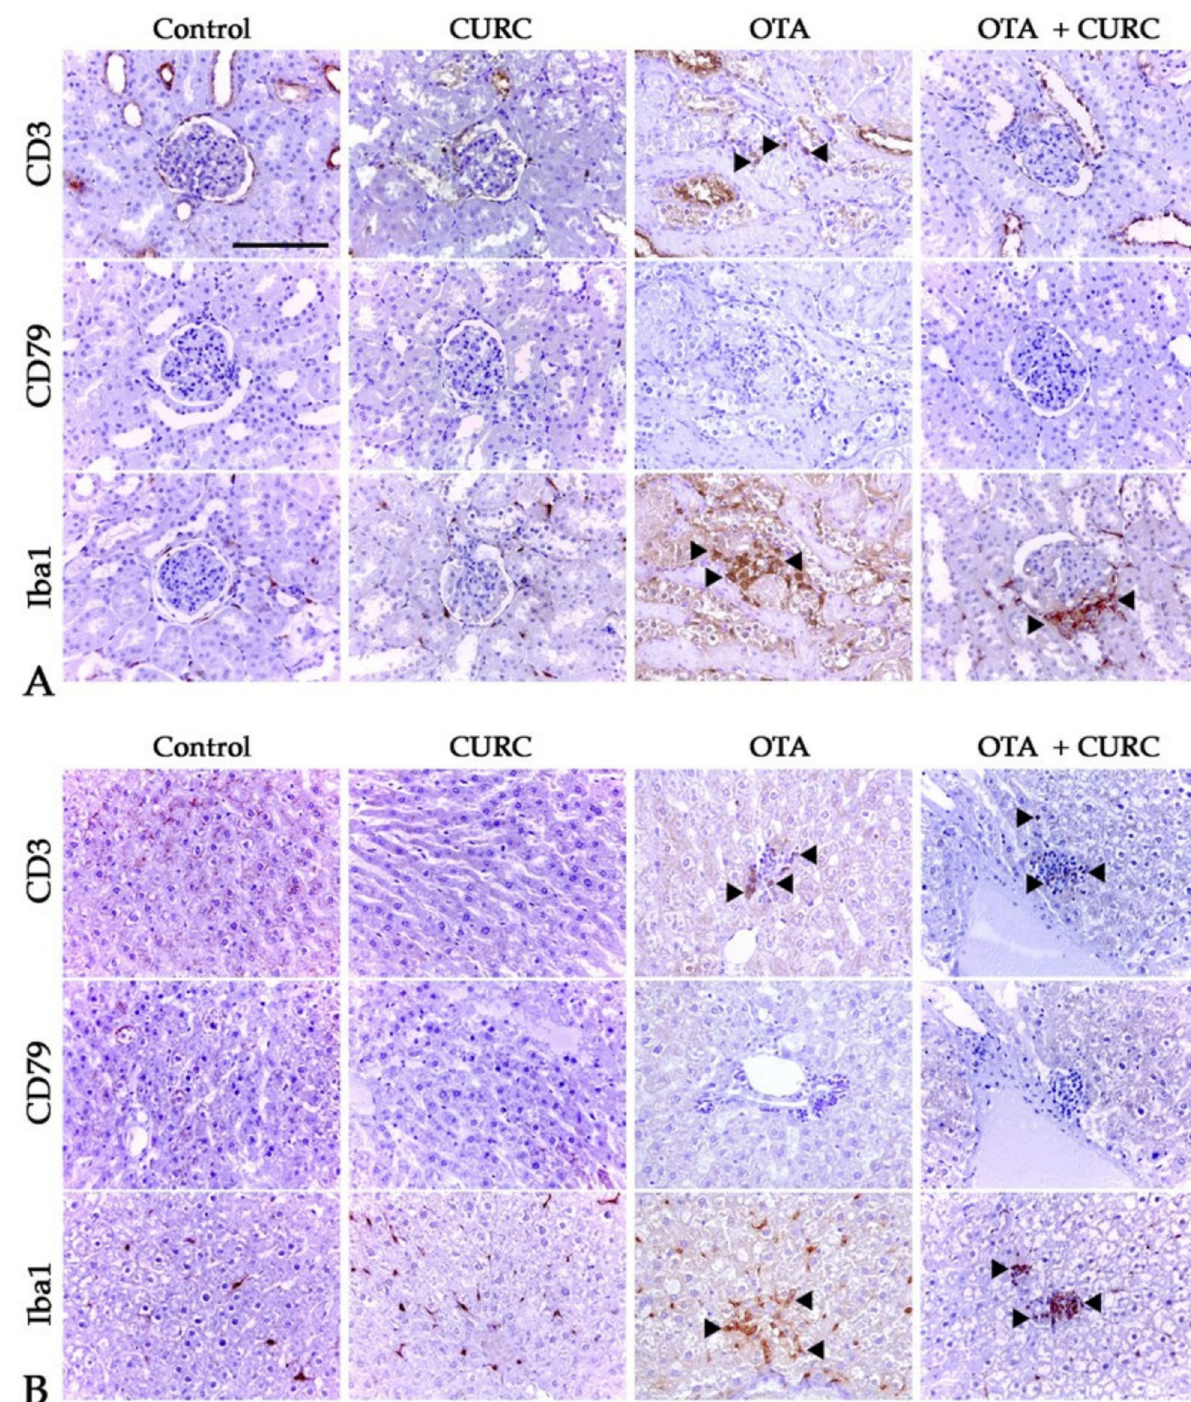
Figure 10. Immunohistochemical characterization of the inflammatory infiltrates in kidney ( A ) and liver ( B ) of rats. Control group; CURC group (100 mg/kg b.w. of CURC); OTA group (0.5 mg/kg b.w. of OTA); OTA + CURC group (0.5 mg/kg b.w. of OTA plus 100 mg/kg b.w. of CURC). Immunohistochemistry, 40 × magnification, scale bar = 100 µ m. Arrowheads indicate positive